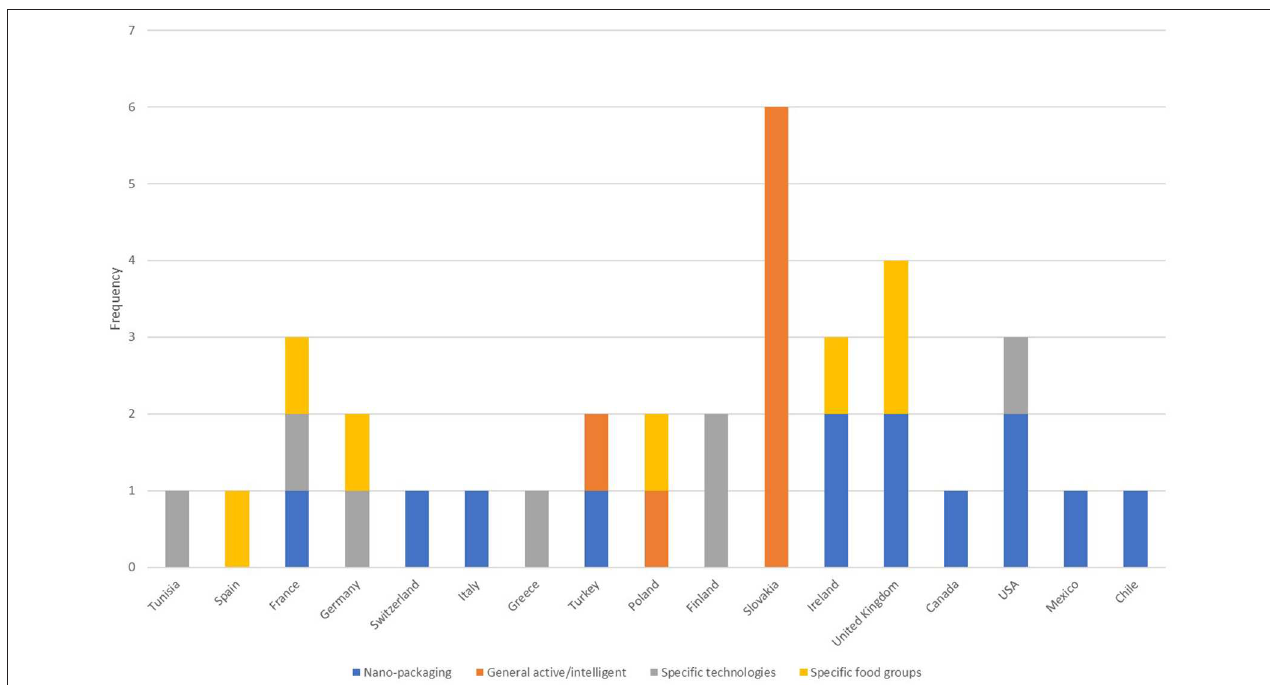
FIGURE 4 | Locations of empirical data collection (some studies collected data in multiple countries).